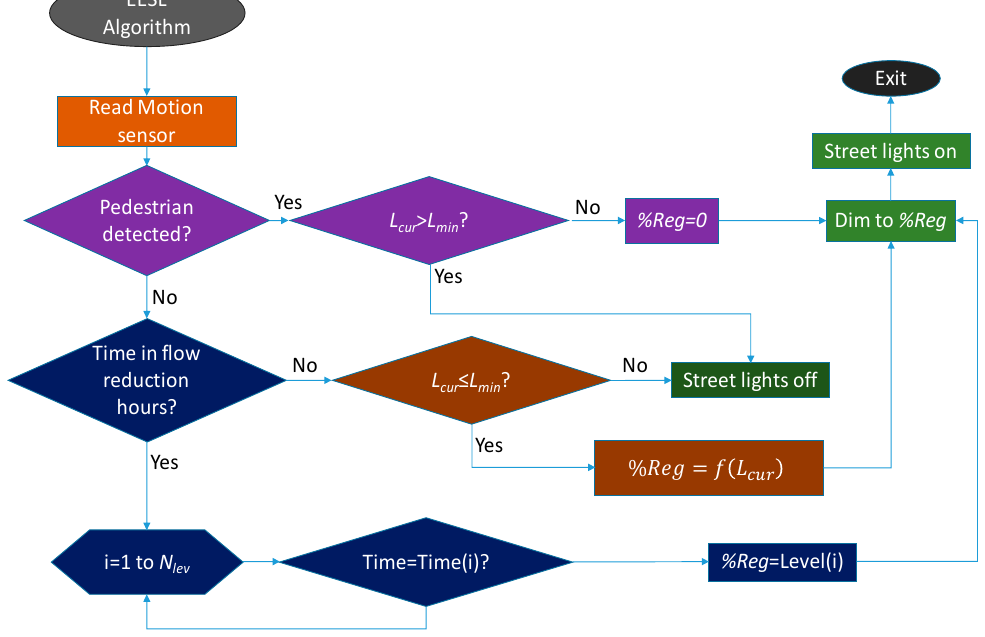
Figure 10. Energy efficient street lights algorithm flow chart.